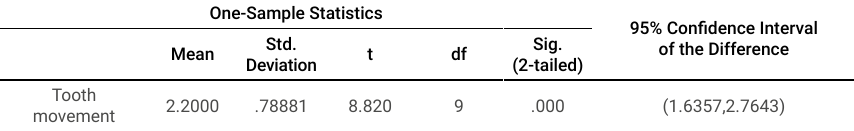
Table 4. Changes in tooth movement after initial alignment